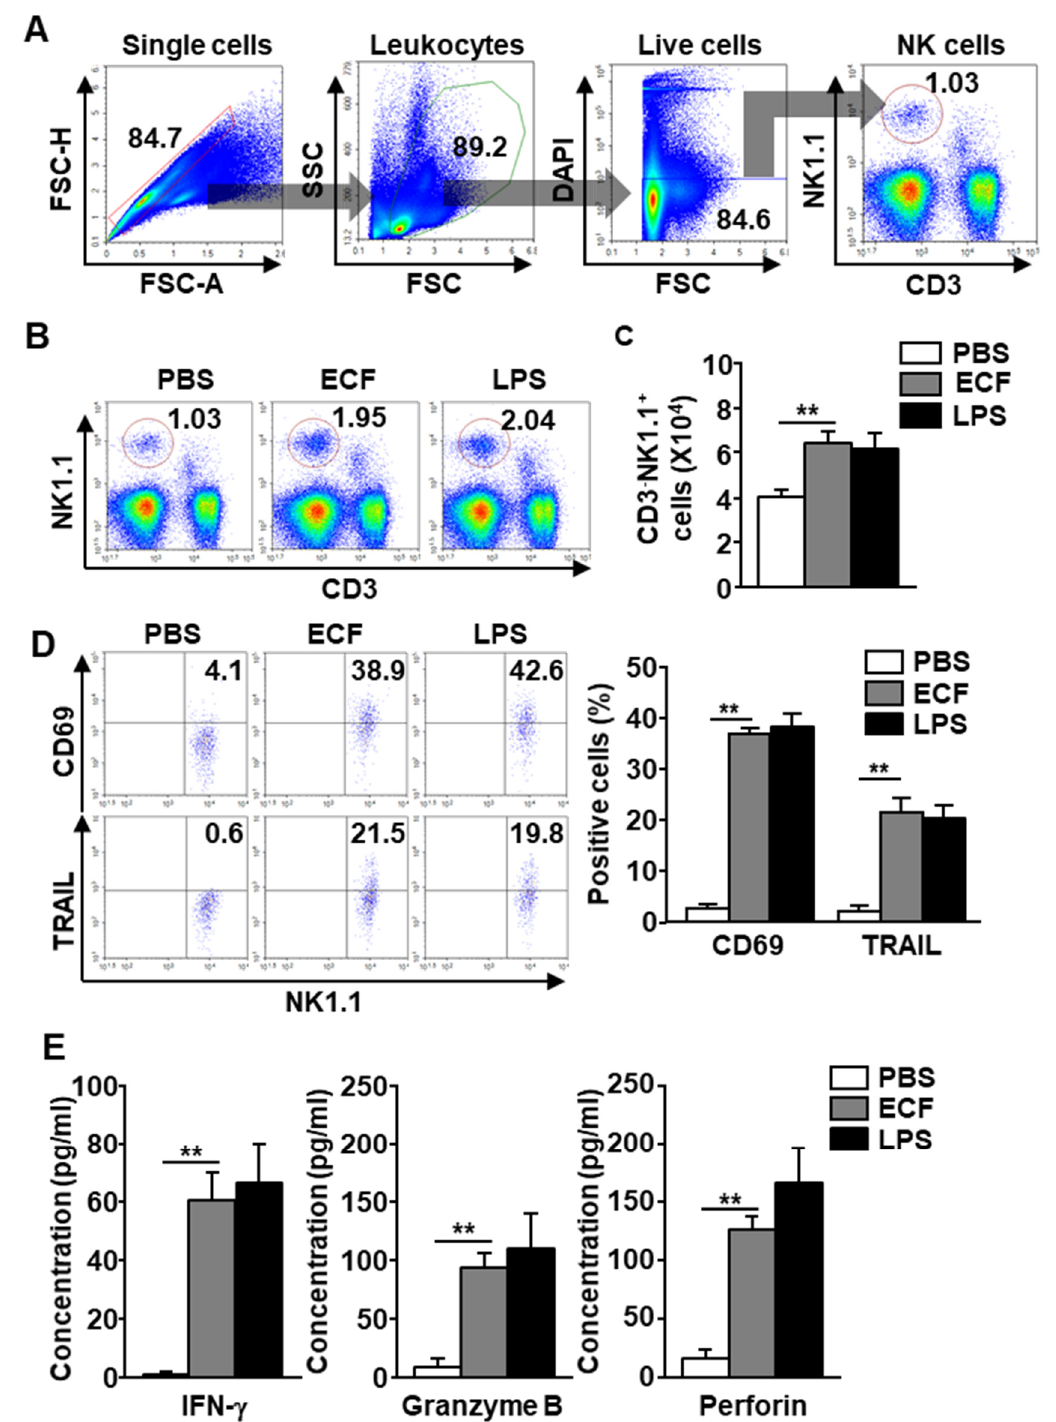
Figure 2. Natural killer (NK) cell activation by ECF. Twenty-four hours after 50 mg/kg ECF administration intranasally, the mLN was harvested from C57BL/6 mice. ( A ) NK cells definition was shown. ( B ) The percentage of NK cells was shown. PBS, phosphate-buffered saline; LPS, lipopolysaccharide. ( C ) Average of NK cell number in the mLN ( n = 6, two-way analysis of variance, ** p < 0.01). ( D ) Surface activation markers, CD69 and tumor necrosis factor-related apoptosis-inducing ligand (TRAIL) expression levels in mLN NK cells were shown ( left panel ). Mean number of CD69 and TRAIL positive cells in mLN NK cells were shown ( right panel , n = 6, two-way analysis of variance, ** p < 0.01). ( E ) Concentration of interferon (IFN)- γ , granzyme B, and perforin levels in BAL fluid was shown. ( n = 6, two-way analysis of variance, ** p < 0.01).